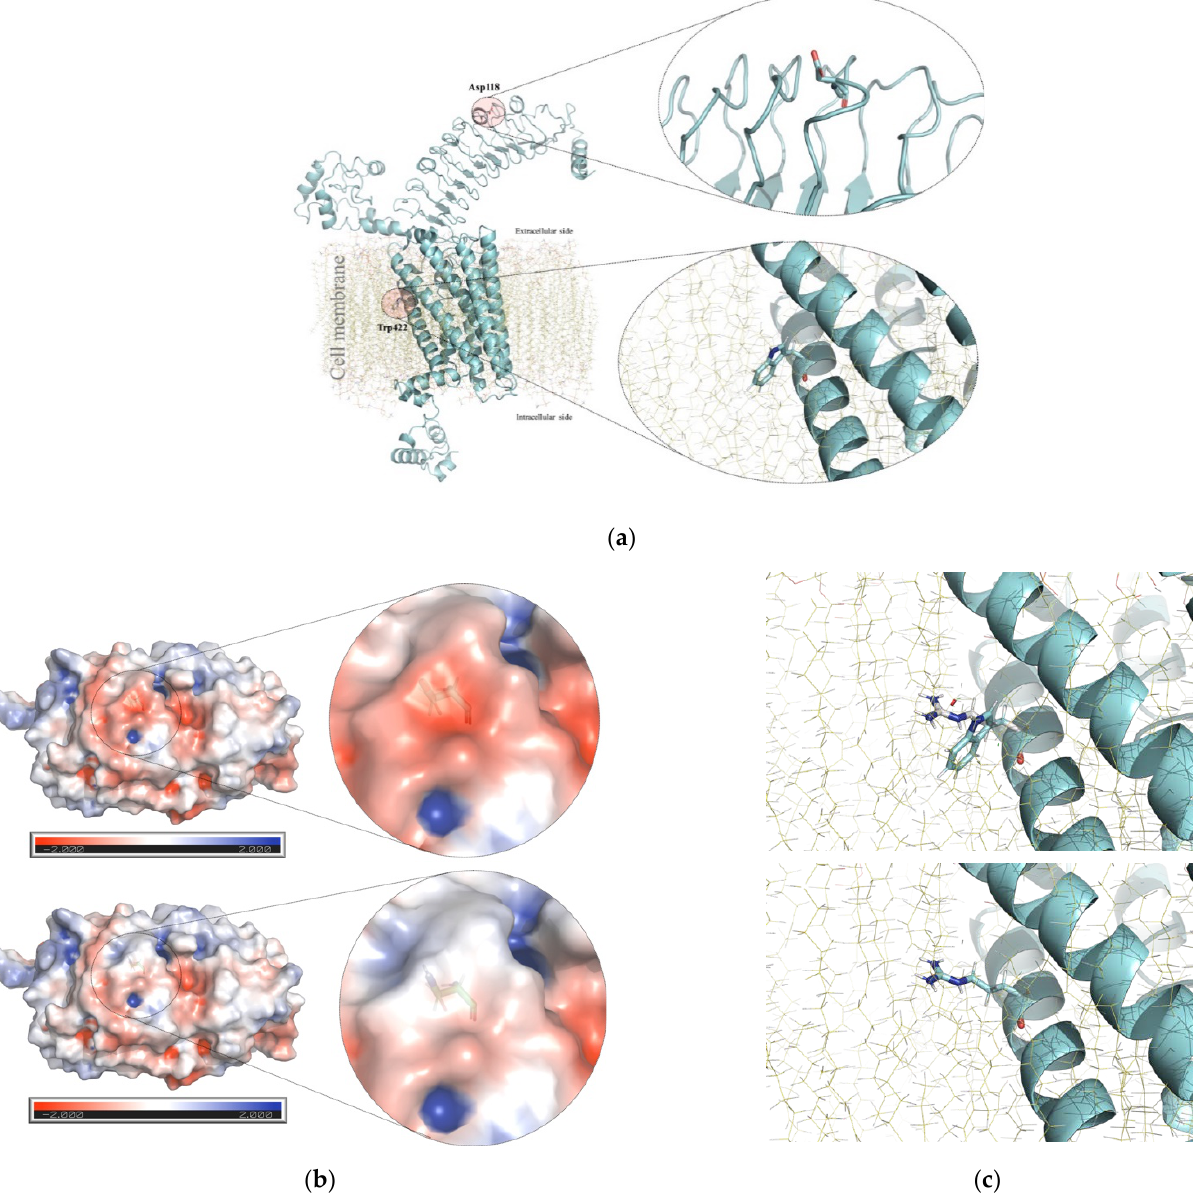
Figure 2. TSH receptor modeling. ( a ) Schematic representations of the complete in silico model of TSH receptor obtained with the PyMOL software, indicating the positions of Asp118 and Trp422 (including a close-up, right) involved in the substitutions identified in HC-324. ( b ) Electrostatic potential surface modeling of the convex side of the crystallographic structure (PDB code: 2XWT) of the wild-type (upper) and mutant (lower) proteins, showing that the Asp-to-Asn substitution at residue 118 induces a change from a negative (zoomed at the top) to a positive (zoomed at the bottom) electrostatic potential surface. ( c ) Close-up of position 422 in the first transmembrane domain of TSH receptor with modeling of superimposed Trp and Arg amino acids (top). The substituted amino acid residue (bottom) reveals close contact with the cell membrane.